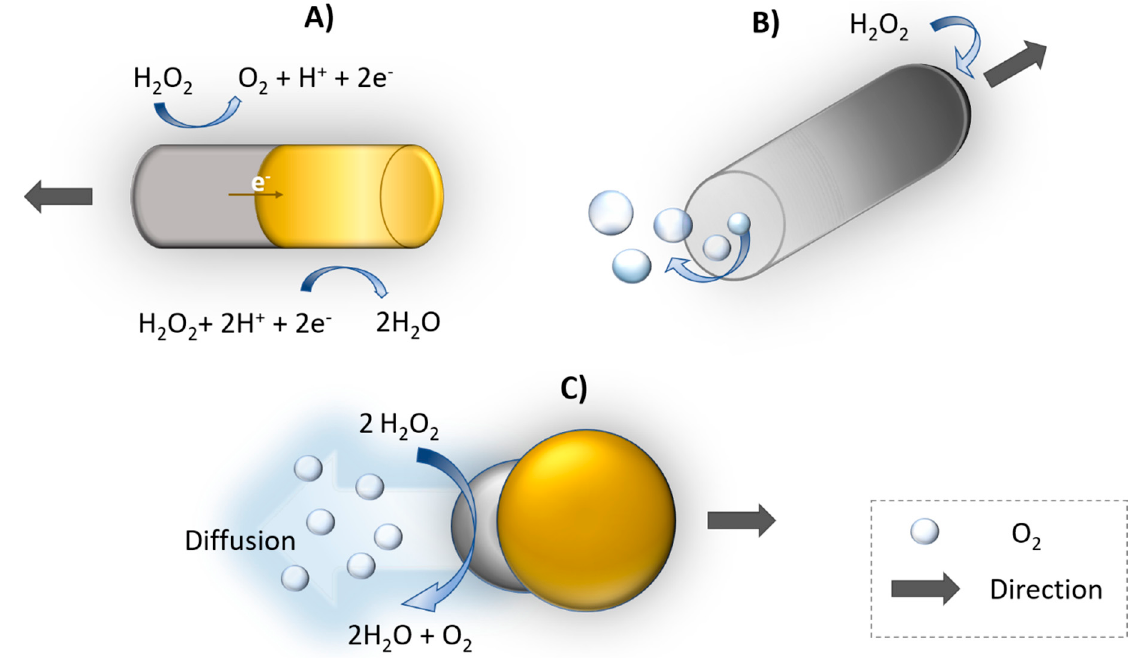
Figure 5. Schematic illustration of propulsion mechanisms of catalytically propelled nanomotors. ( A ) Self-electrophoresis, ( B ) bubble propulsion, ( C ) diffusiophoresis (example of composition Au-yellow, Pt-gray).